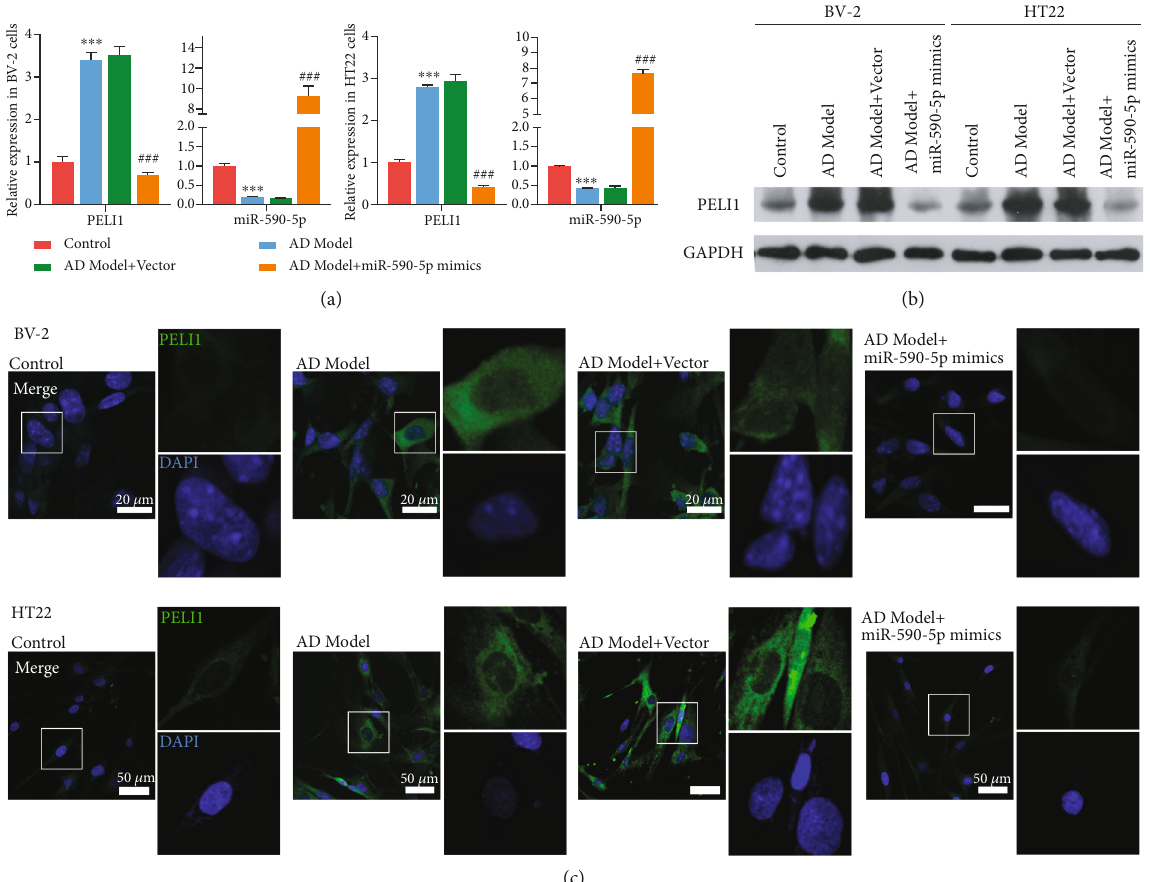
Figure 3: E ff ect of miR-590-5p overexpression on PEIL1 in A β -induced BV-2 and HT22 cells. (a) The mRNA levels of miR-590-5p and PELI1 in BV-2 or HT22 cells treated with A β (AD model), A β +vector, and A β +miR-590-5p mimics, respectively, by qPCR. (b) The protein levels of PELI1 in BV-2 or HT22 cells treated with A β (AD model), A β +vector, and A β +miR-590-5p mimics, respectively, by western blotting. (c) The PELI1 expression in BV-2 or HT22 cells treated with A β (AD model), A β +vector, and A β +miR-590-5p mimics, respectively, by cell immuno fl uorescence. Each experiment was repeated three times. ∗∗ P < 0 : 01 , ∗∗∗ P < 0 : 001 vs. control group; ### P < 0 : 001 vs. AD model+vector